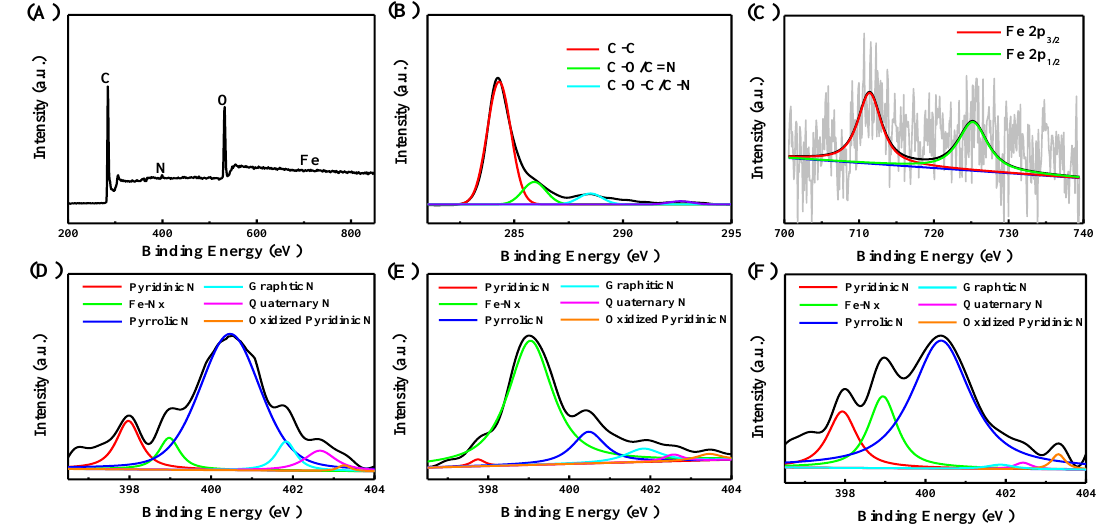
Figure 4. ( A ) XPS survey spectra of Fe 2 O 3 /N-PCs-850; High-resolution C 1s ( B ) and Fe 2p ( C ) XPS spectrum of Fe 2 O 3 /N-PCs-850; High-resolution N 1s XPS spectrum of Fe 2 O 3 /N-PCs-800 ( D ), Fe 2 O 3 /N-PCs-850 ( E ) and Fe 2 O 3 /N-PCs-900 ( F ).